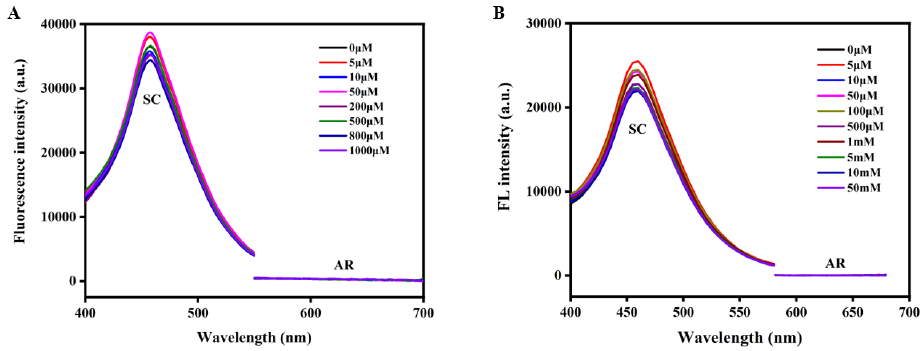
Figure 3. Fluorescence spectra of SC and AR under the different concentrations of Ag + ( A ) and H 2 O 2 ( B ).